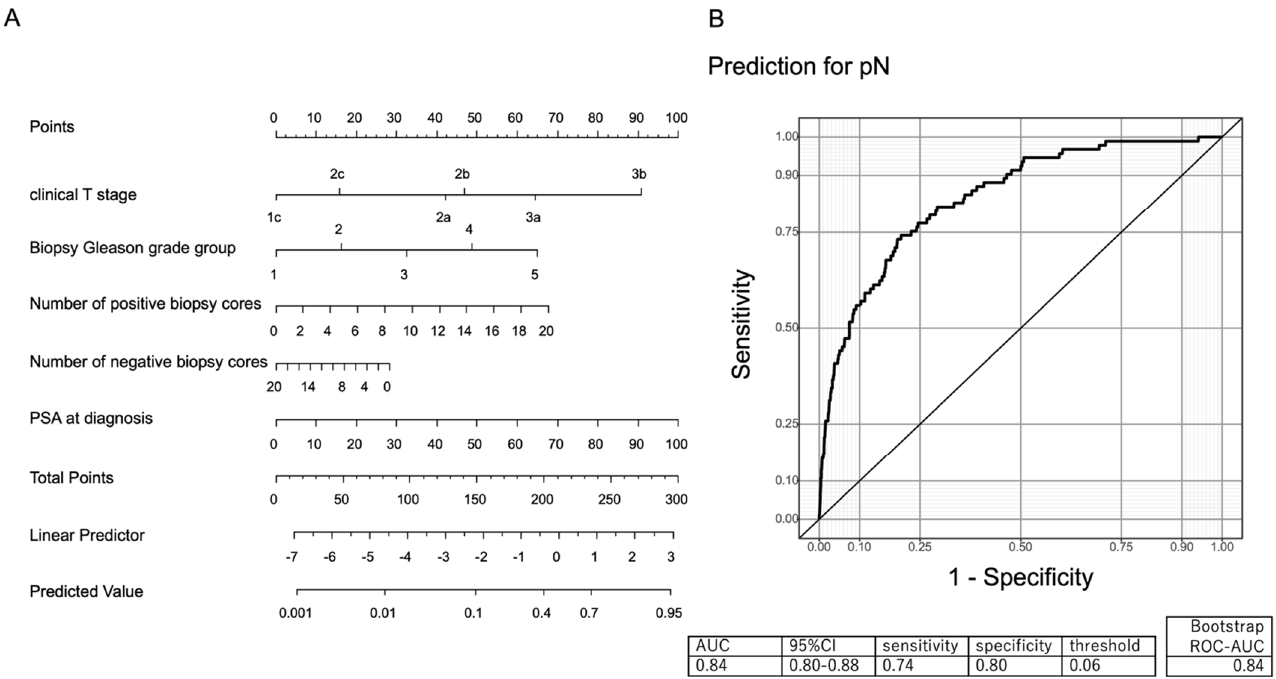
Figure 1. ( A ) Our nomogram predicting the probability of prostate cancer (PCa) with lymph node involvement (LNI) in patients undergoing robot-assisted radical prostatectomy and pelvic lymph node dissection using clinical T stage, biopsy Gleason grade, number of positive biopsy cores, number of negative biopsy cores, and prostate-specific antigen at diagnosis. ( B ) Receiver operating characteristic curve of predictive accuracy for PCa with LNI.